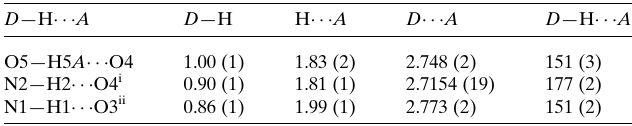
Table 2 Hydrogen-bond geometry (A˚ , (cid:3) ) for the ethanol solvate.